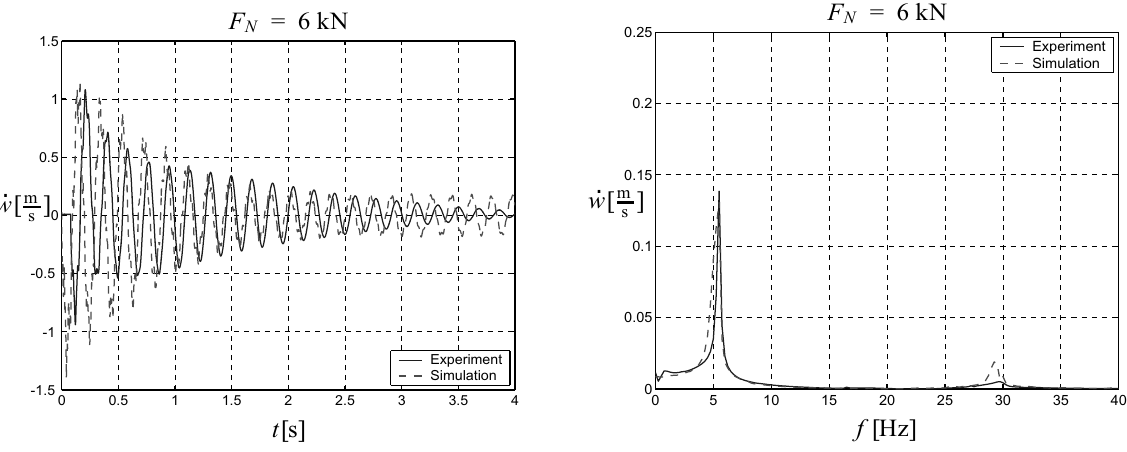
Fig. 4. Time- and frequency-domain comparison between numerical and experimental velocities for the case of a freely-vibrating double beam with contact normal force F N = 6 kN. At the free end of the double beam, a weight of 20 N was applied and then set free (snap-back excitation). Figure 4 shows a comparison of simulated and measured velocities of the free vibration. There is a good agreement between simulation and experiment in both time and frequency domain. (Note: in the measured velocity curve a certain exponential decay can be observed. This is due to damping mechanisms other than friction, that were not taken